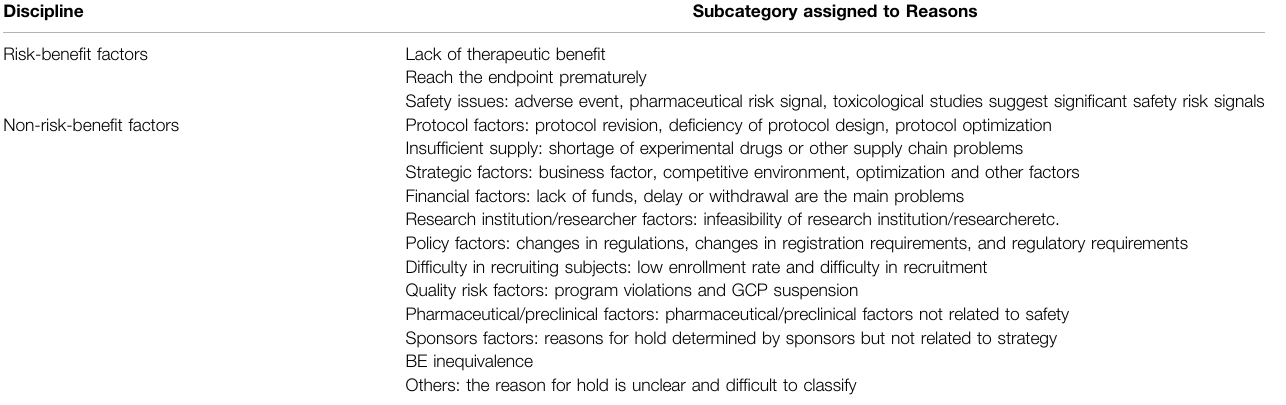
TABLE 1 | Classi fi cation of suspension justi fi cations. Discipline Subcategory assigned to Reasons Risk-bene fi t factors Lack of therapeutic bene fi t Reach the endpoint